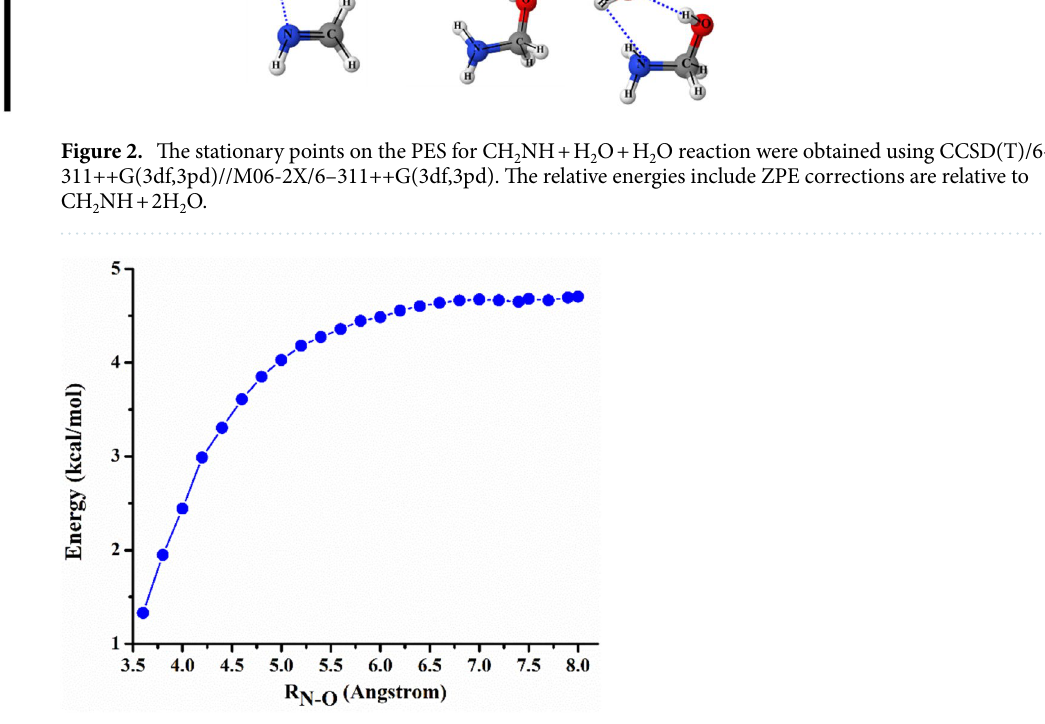
Figure 3. Zero-point corrected potential energy profile for the dissociation of the CH 2 NH ⋯ H 2 O as functions of R N-O